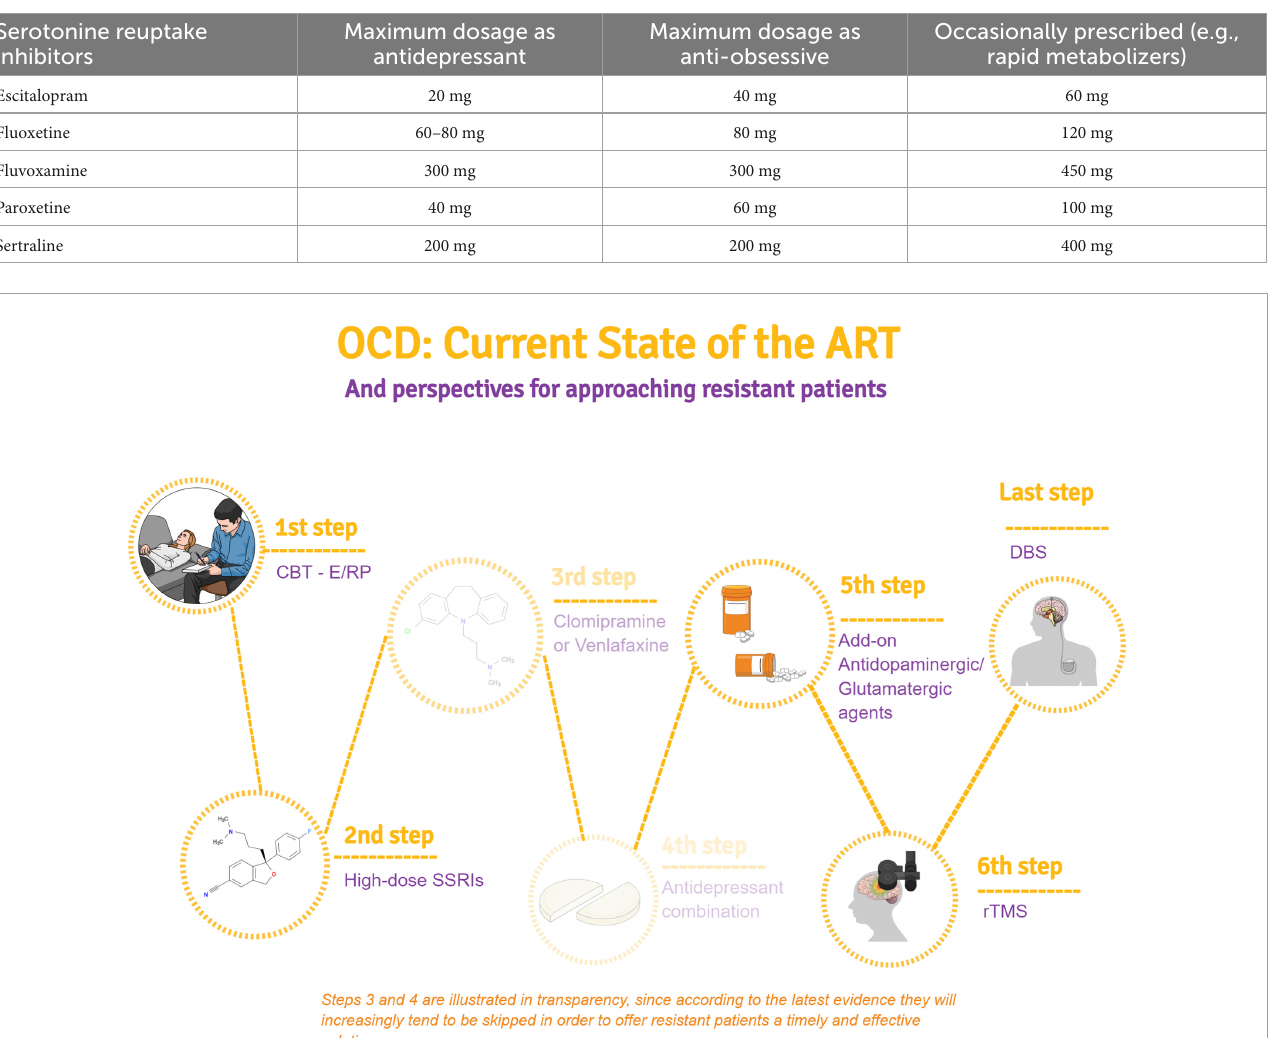
TABLE 1 Comparison of maximum dosage of selective serotonin re-uptake inhibitors (SSRIs) when used as antidepressants vs. anti-obsessive agents.